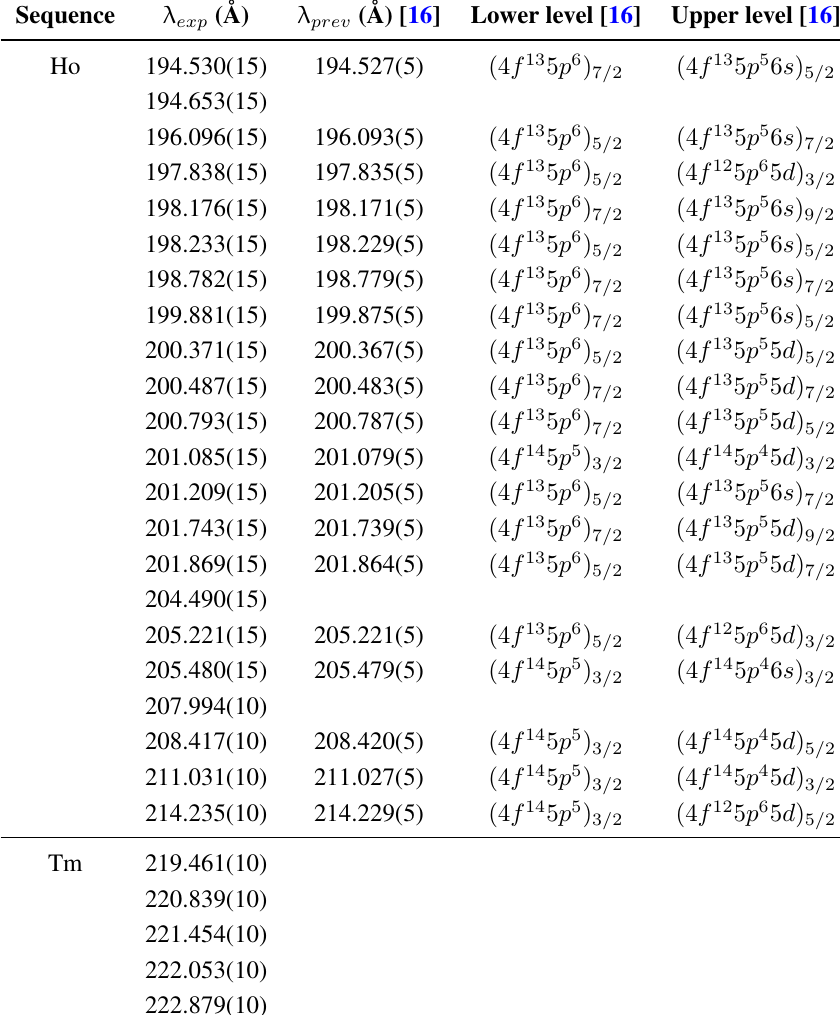
Table 1. Measured line positions in the Tm-like W VI and Ho-like W VIII spectra. λ experimental wavelengths from this work and λ W VIII by Ryabtsev et al.